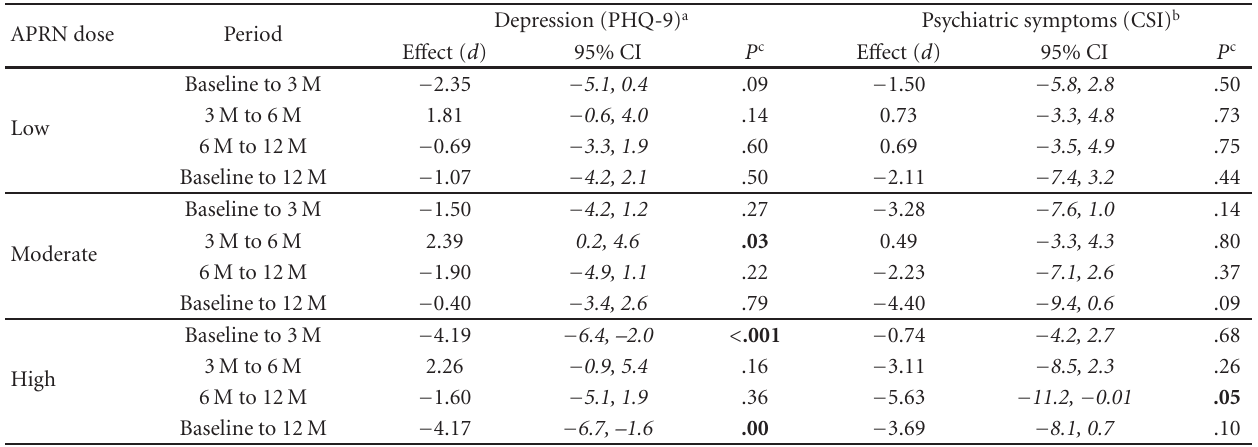
Table 3: Depression and psychiatric symptom outcomes: average treatment e ff ects for patients receiving an advanced practice psychiatric nurse intervention, by dose versus usual